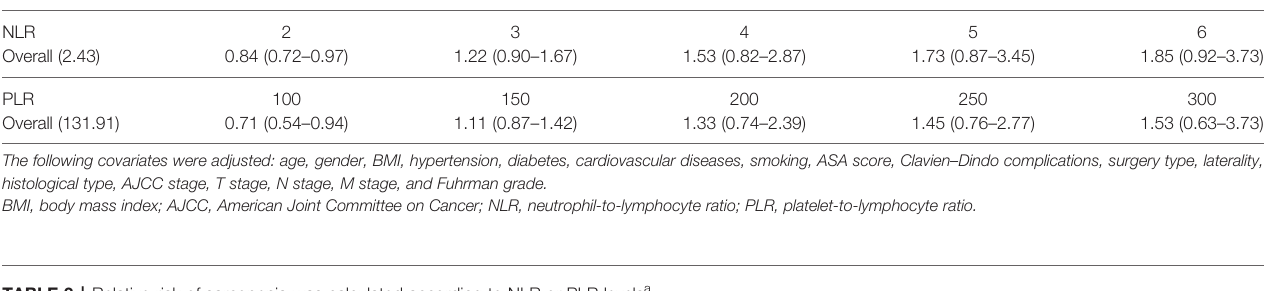
TABLE 3 | Relative risk of sarcopenia was calculated according to NLR or PLR levels a . Characteristic